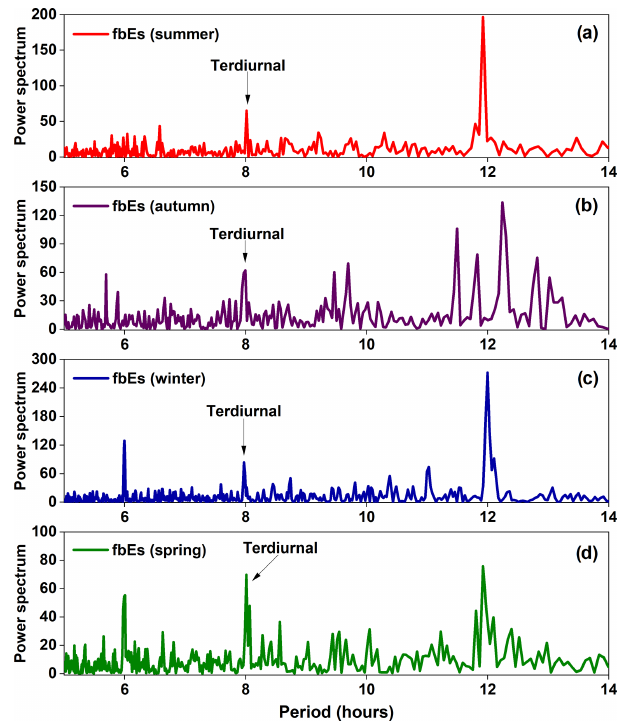
Figure 6. Periodogram analysis of the fbE s with the power spec- trum representations of (a) summer, (b) autumn, (c) winter, and (d) spring. The best-fitting peaks correspond to the 99% confidence interval of the fbEs